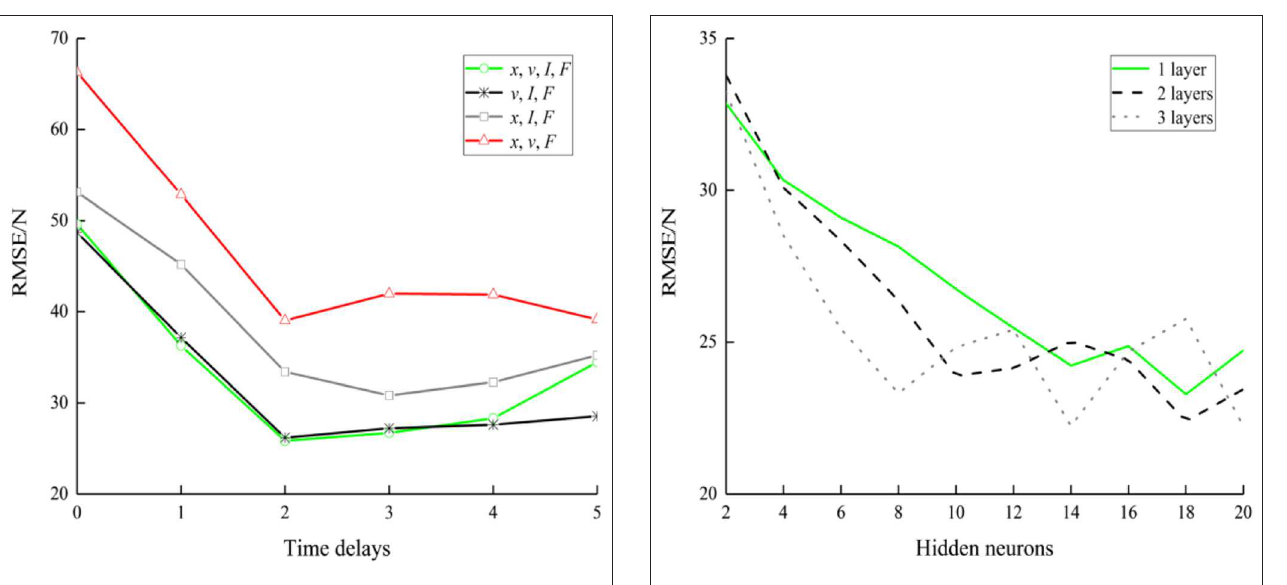
FIGURE 4 | The root mean square error (RMSE) under different input combinations.